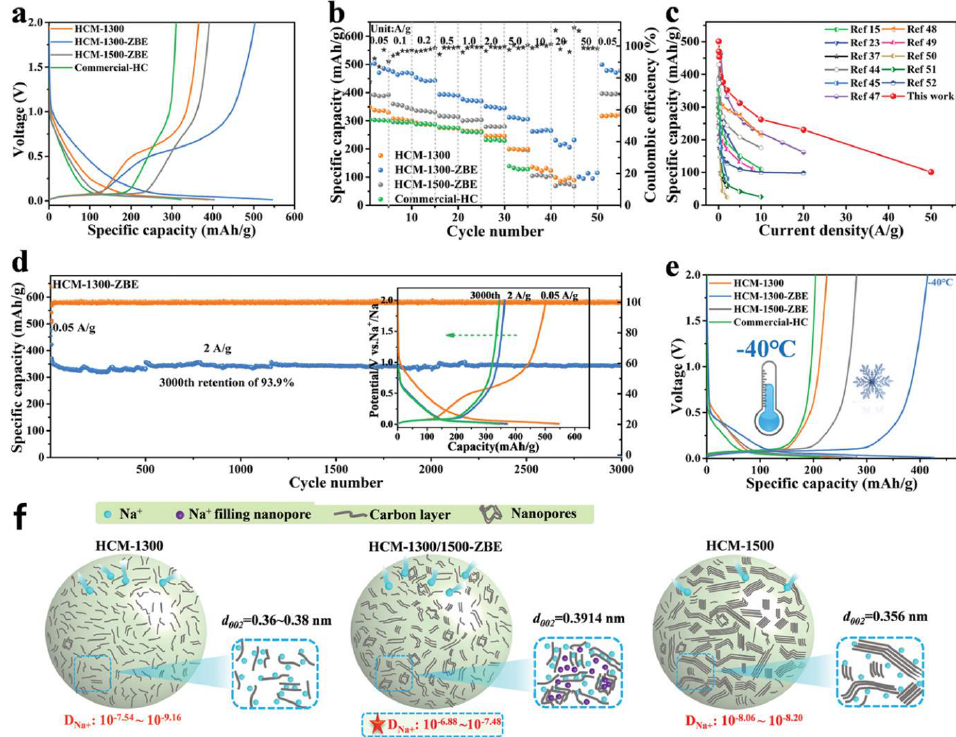
Figure 5. Electrochemical characterizations. ( a ) Galvanostatic charge/discharge (GCD) curves of HCM-1300, HCM-1300-ZBE, HCM-1500-ZBE, and commercial HC with the voltage range from 0.01 V to 2 V at 50 mAh g −1 of the second cycle. ( b ) Rate performances at 0.05, 0.1, 0.2, 0.5, 1.0, 2.0, 5.0, 10,